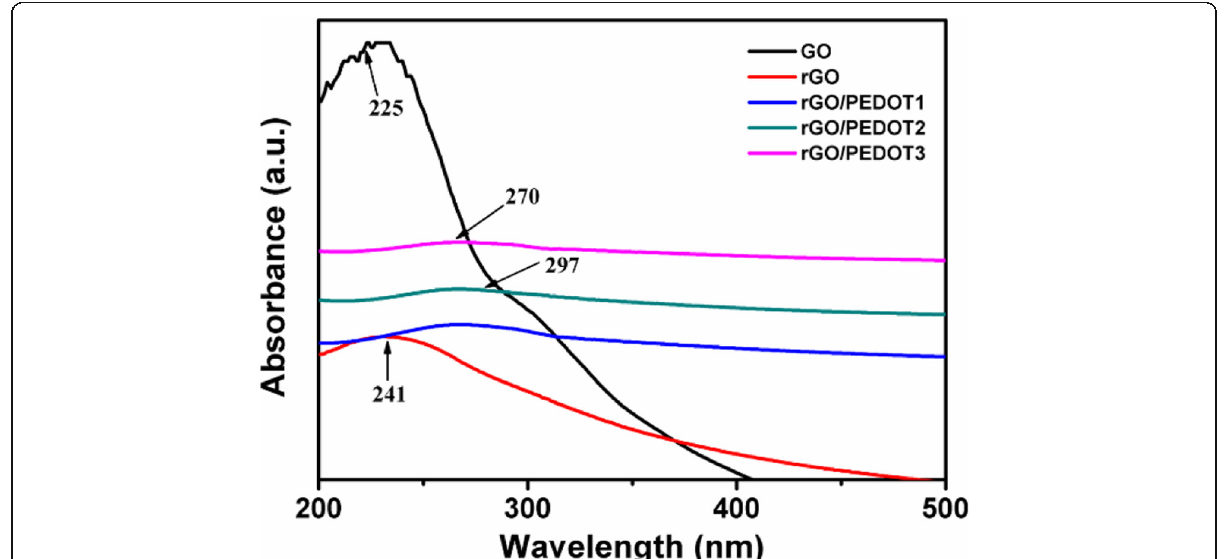
Fig. 2 UV-Vis spectrum of GO, hydrothermal-treated rGO, and hydrothermal-polymerized